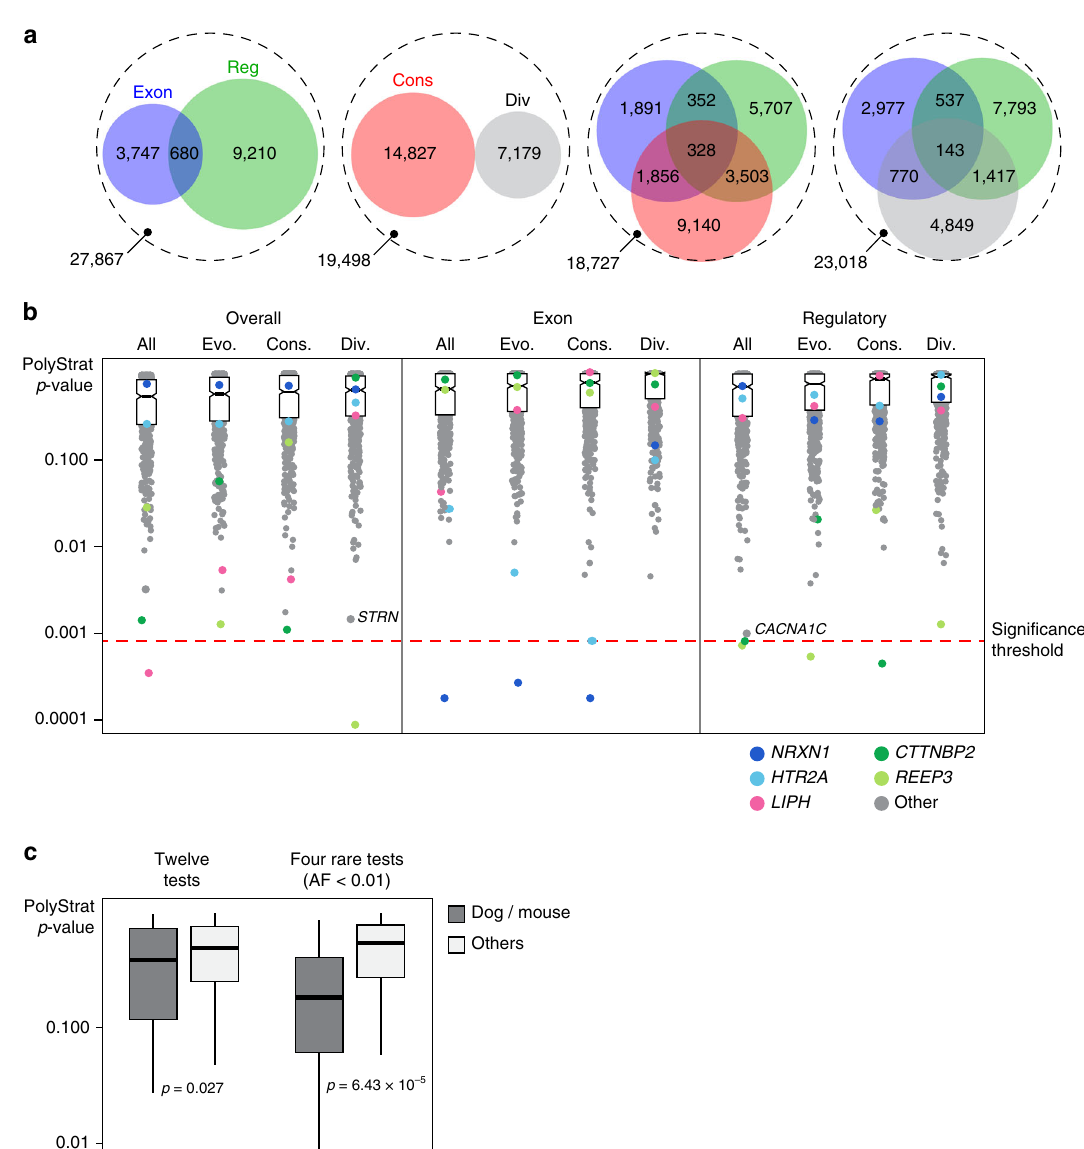
Fig. 1 PolyStrat analysis of pooled-targeted-sequencing data. a Venn diagrams showing the number of SNPs annotated as functional and/or conserved by PolyStrat. Each of the four dashed circles represents the 41,504 total high-con fi dence SNPs detected. Within each circle , SNPs are strati fi ed by their annotations. Each colorful interior circle represents SNPs annotated as exonic ( blue ), regulatory ( green ), conserved ( red ), or diverged ( gray ) bases. SNPs with multiple annotations are represented by circle overlaps , and SNPs without any of the included annotations are within the white space of the dashed outer circle . b PolyStrat p -values for 608 genes ( circles ) strati fi ed by the 16 (12 shown) annotation categories tested show that just fi ve genes ( NRXN1 , HTR2A , LIPH , CTTNBP2 , and REEP3 ) have p -values below the experiment-wide signi fi cance threshold after correction for multiple testing ( red dashed line ). Two moderately associated, OCD-relevant genes discussed in the text are also noted ( STRN and CACNA1C ). “ Evo ” ( = evolutionary) are SNPs either conserved ( “ Cons ” ) or divergent ( “ Div ” ). The vast majority of genes tested fail to exceed the signi fi cance threshold, with the median p -value for each category shown as a dark black line separating two boxes representing the 25 – 75% quantile. Notch in boxes shows the 95% con fi dence interval around median. c p -values for the fi ve genes robustly implicated in animal models of OCD are signi fi cantly lower than p -values for the rest of the genes in our sequencing set (603 genes), and this difference increases when just rare variants are tested. The solid horizontal line shows median p -value, the boxed area the 25 – 75% quantiles, and the vertical black lines extend from the minimum to maximum p -values observed. AF, allele